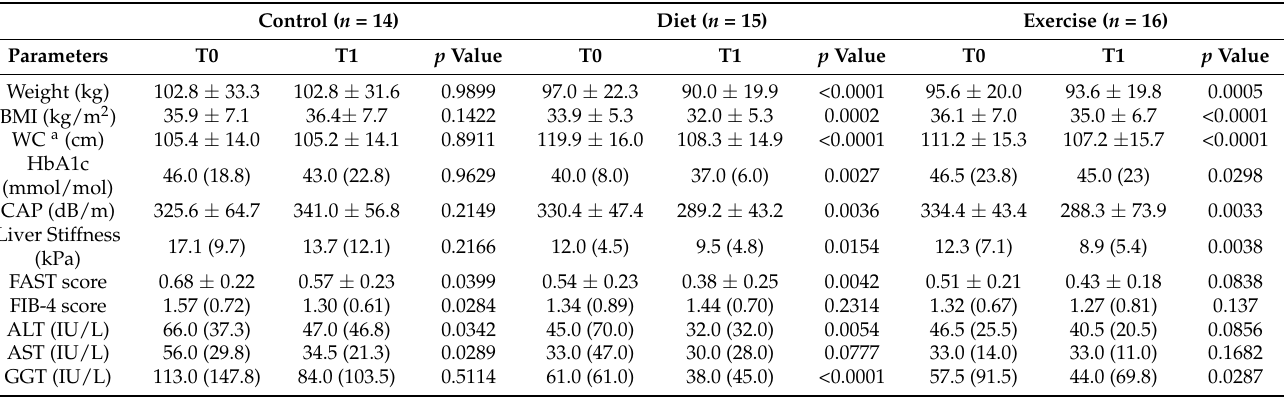
Table 2. Changes in clinical parameters from baseline (T0) to week 13